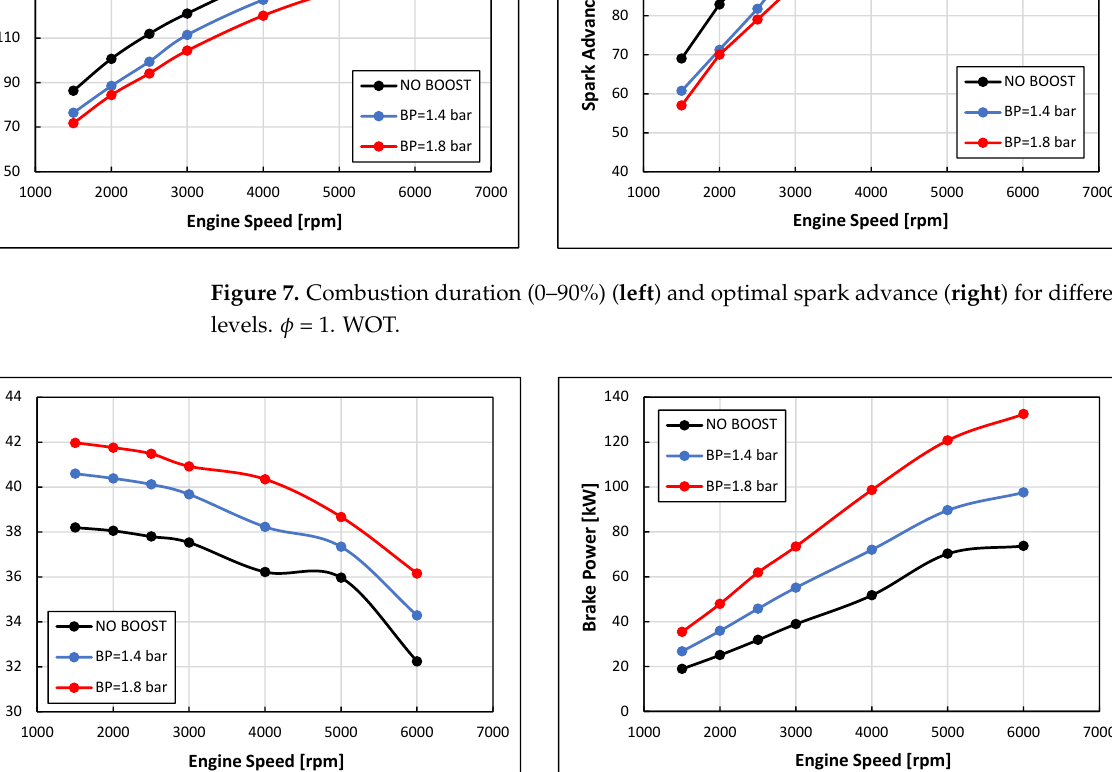
Figure 8. Brake efficiency ( left ) and brake power ( right ) for different boost levels. ϕ = 1. WOT.